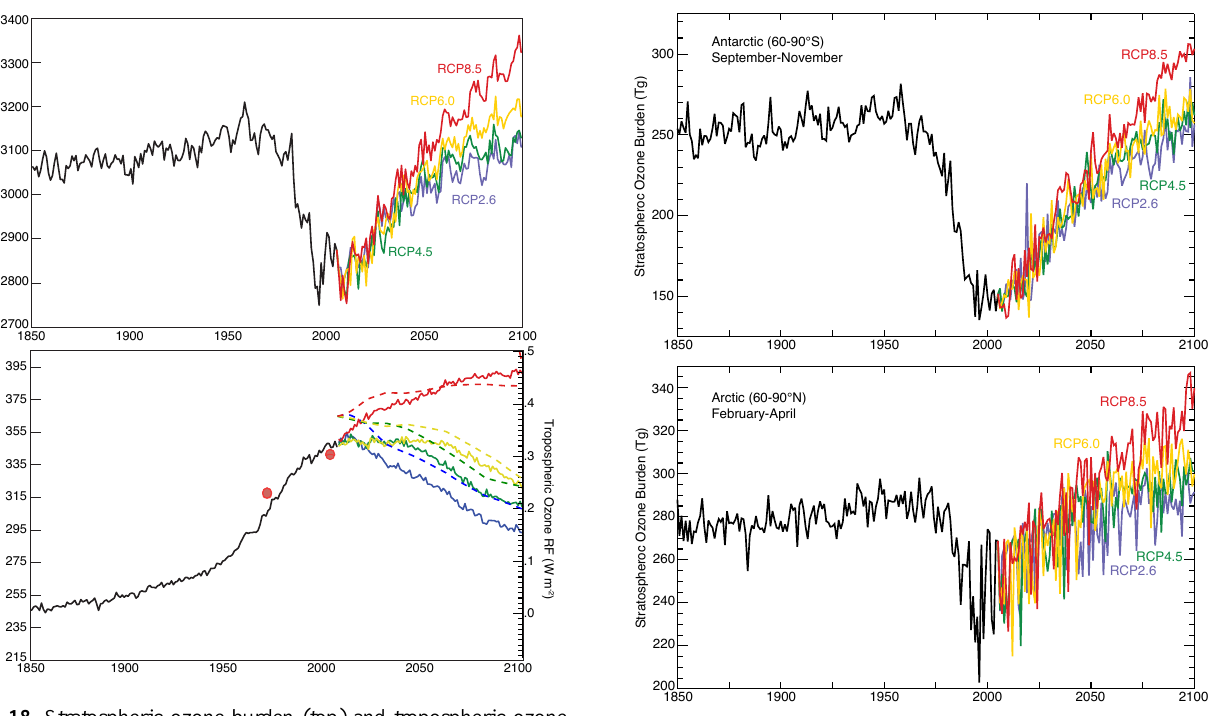
Fig. 19. High latitude stratospheric ozone burdens (Tg) during